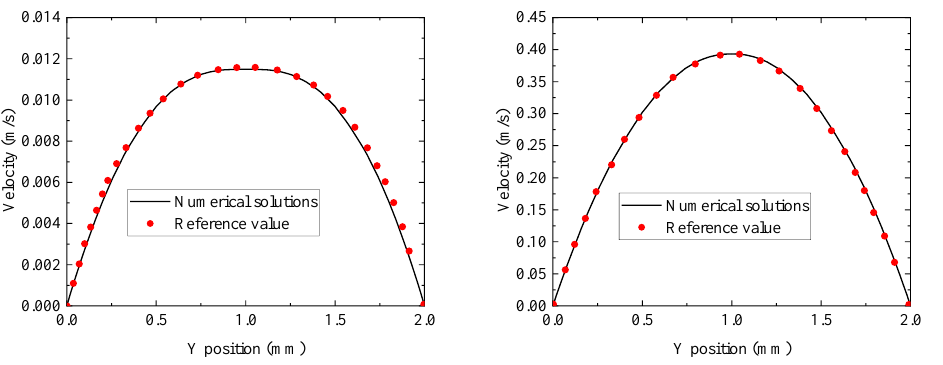
Figure 5. Geometry of the back-step flow used in Ref. [42].